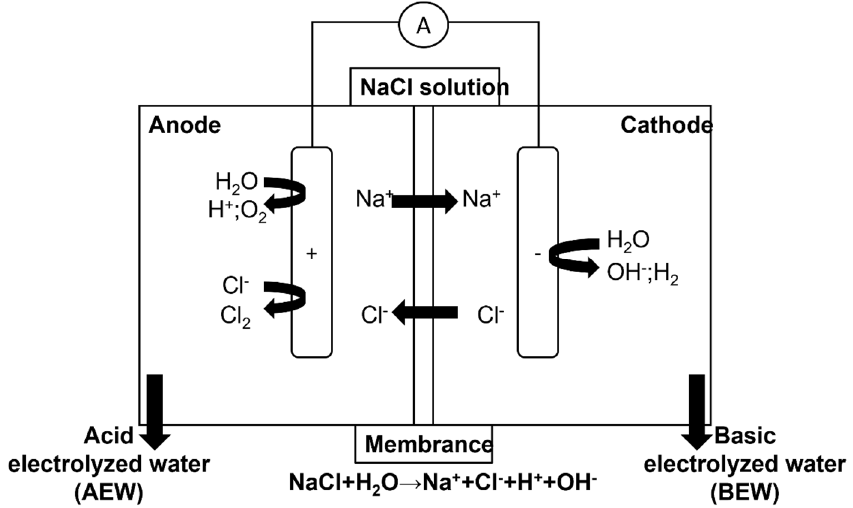
Table 1. The characteristics of EW.